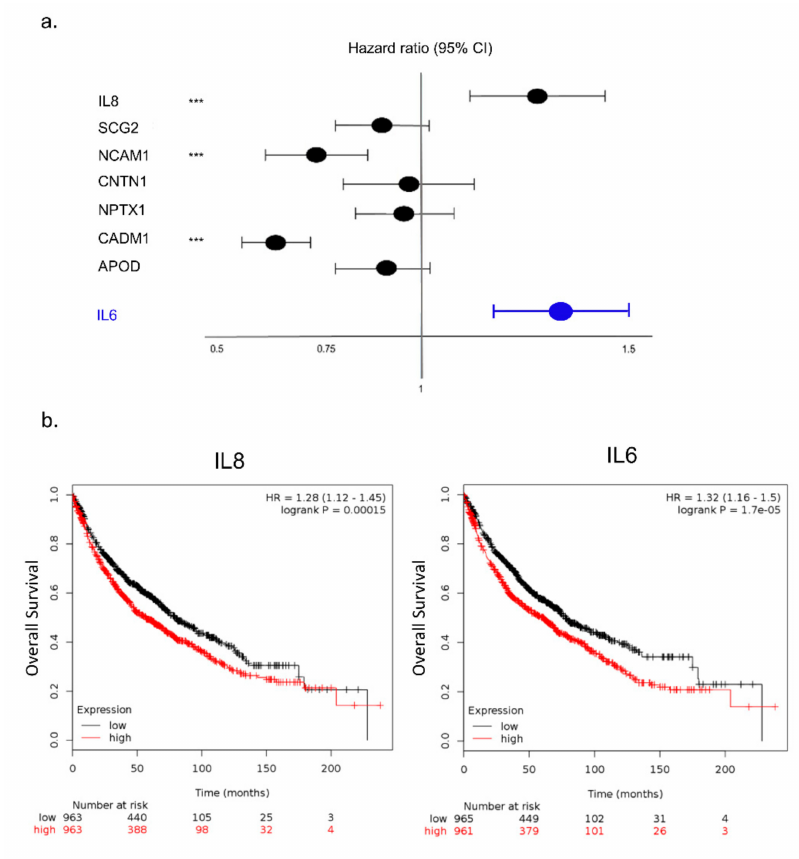
Figure 5. Interleukin (IL)-8 is associated with poor prognosis in non-small cell lung cancer (NSCLC). ( a ) Forest plot for each tumor biomarkers (IL-8, SCG2, NCAM1, CNTN1, CADM1, NPTX1, and APOD) in NSCLC patients from the dataset available on Kaplan-Meier (KM) plotter database. The hazard ratio (HR) with 95% confidence intervals (CI) determined by Cox proportional hazards model is represented in the horizontal axis. *** represent the statistical significance in NSCLC patient survival outcome ( p < 0.001; log-rank p -value). ( b ) Kaplan-Meier overall survival curves for IL-8 or IL-6 in NSCLC patients from the dataset available on KM plotter [35] database. The resulting p-values for the log-rank test are shown. SCG2: Secretogranin II; NCAM1: Neural Cell Adhesion Molecule 1; CNTN1: Contactin 1; CADM1: Cell Adhesion Molecule 1; NPTX1: Neuronal pentraxin 1; APOD: Apolipoprotein D; IL6: